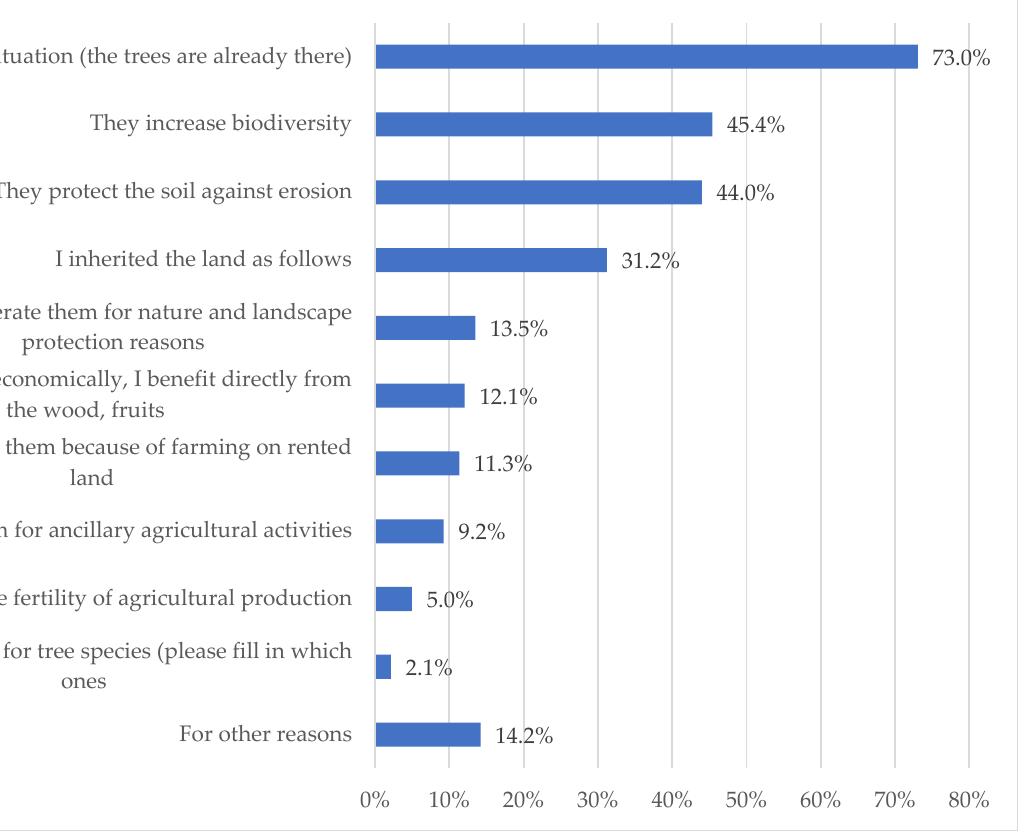
Figure 1. Reasons for growing trees on cultivated land (multiple choice; n = 141).